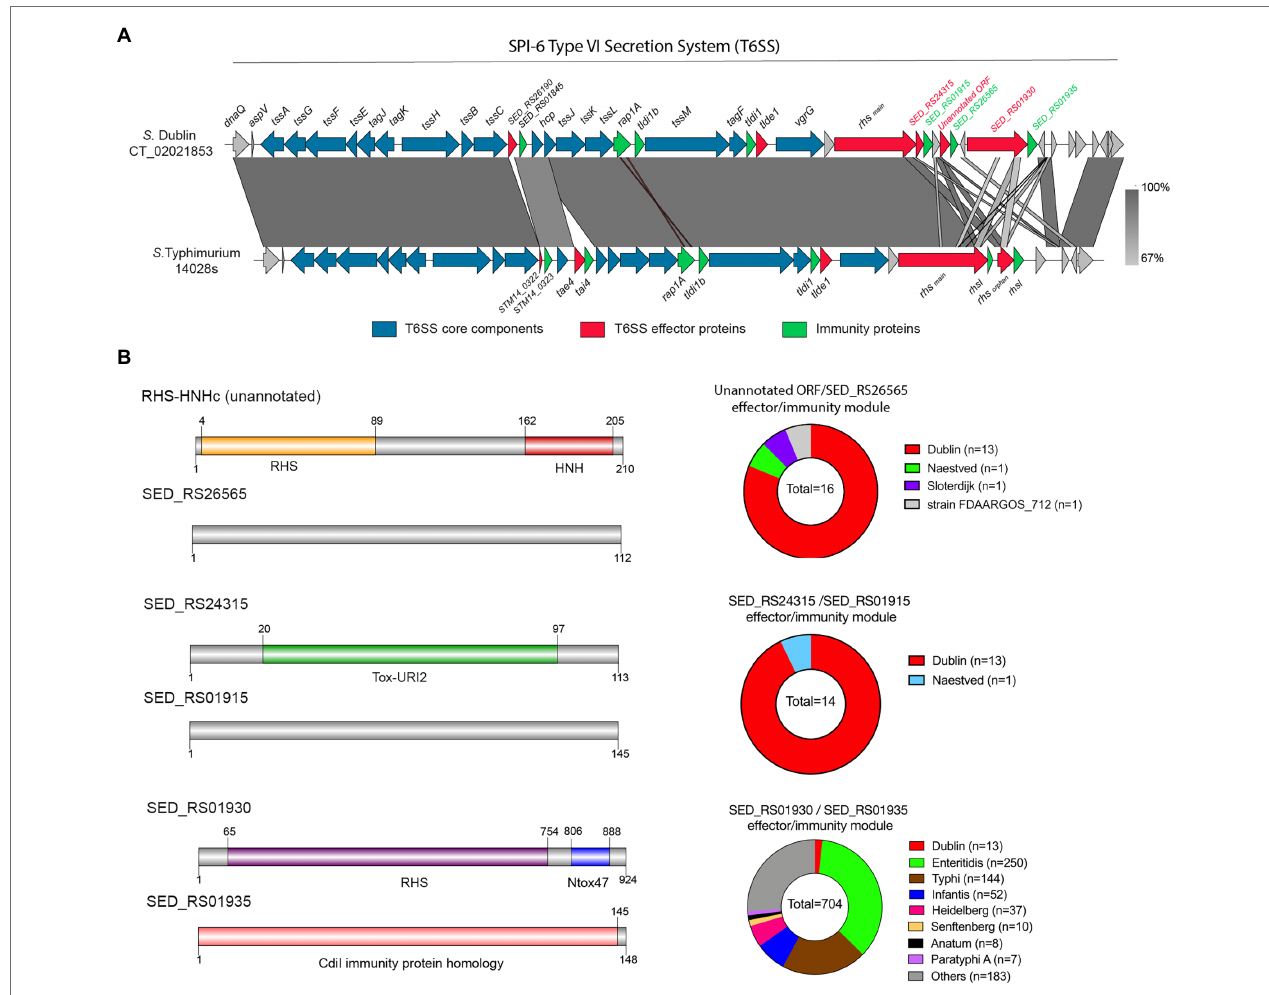
FIGURE 2 | The SPI-6 T6SS gene cluster encodes novel putative Type VI Secretion Systems (T6SS) effector proteins. (A) Comparative genomic analysis of the SPI-6 T6SS cluster of S. Dublin CT_02021853 and S. Typhimurium 14028s. BLASTn sequence alignment was performed and visualized using EasyFig (Sullivan et al., 2011). (B) Schematic representation and distribution among Salmonella genomes of each novel effector and immunity protein identified. Names of genes encoding novel effectors and immunity proteins are highlighted in red and green, respectively. Homologs for each component were identified by BLASTn analyses as described in Materials and Methods.